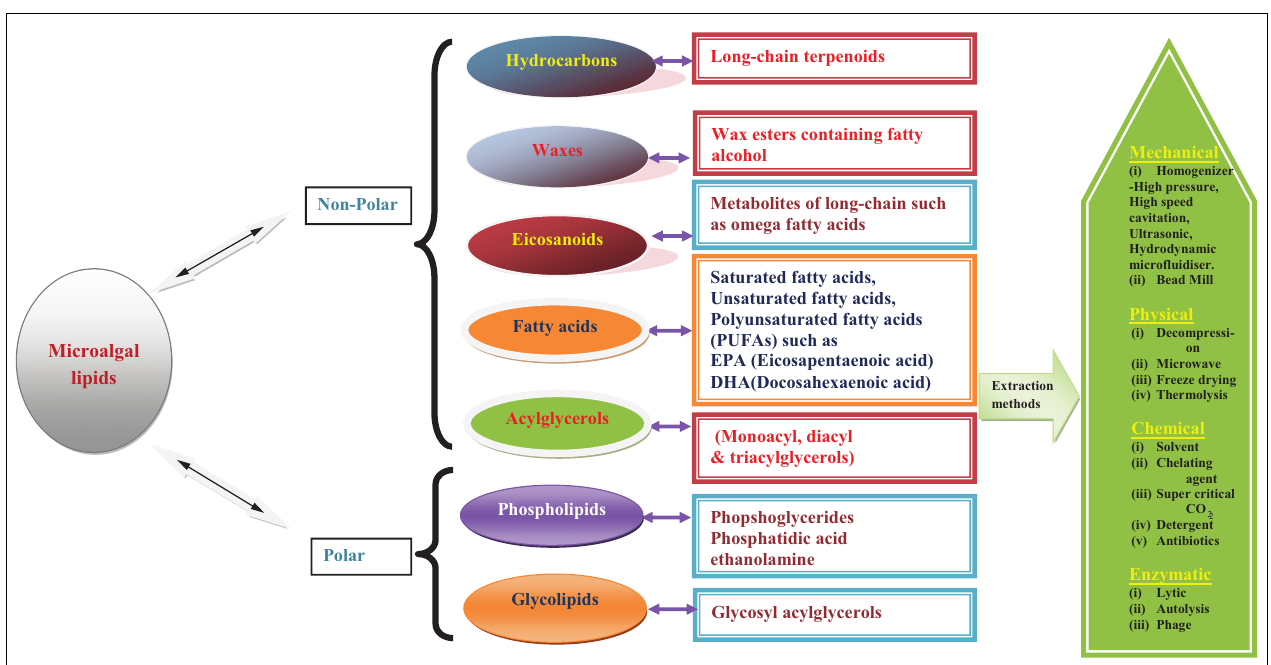
FIGURE 1 | Different classes of microalgal lipids with example and common extraction methods .